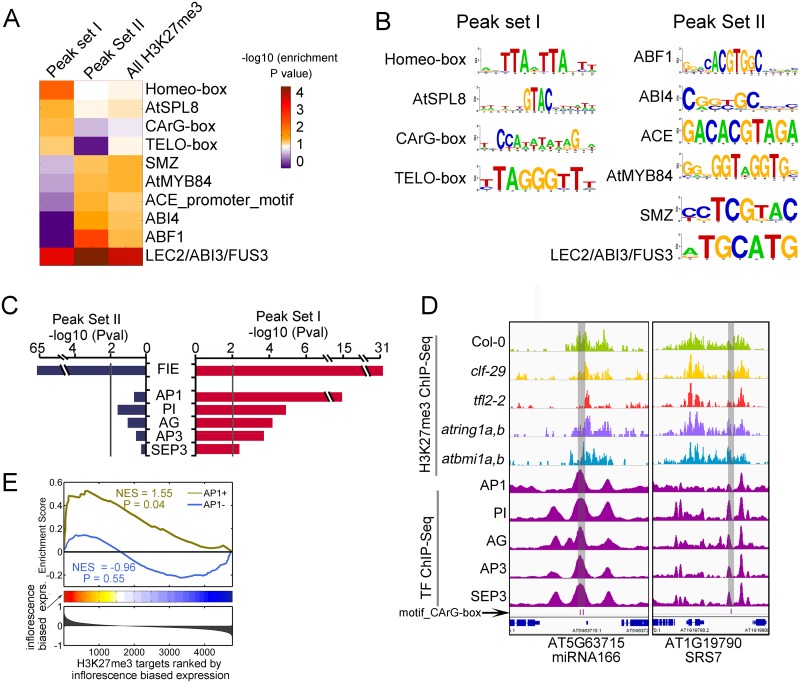
TF binding motifs and TFs whose bindings enriched in peak set I and peak set II.(A) Heatmap showing enriched motifs (P value < 0.01) in either peak set I or peak set II. Their enrichment in H3K27me3 peaks in Col-0 are also shown. (B) Sequence LOGOs of motifs enriched in peak set I and peak set II. (C) Enrichment of the binding sites of FIE and TFs in peak set I. (D) IGV screen shots showing examples of co-occupancy between H3K27me3 in seedlings and the bindings of MADS-box TFs in inflorescence. The motif sites of MADS box TFs are indicated by pink and blue bars at bottom of the screen shots, and are highlighted by grey area. (E) GSEA showing the common target genes of peak set I and AP1 binding peaks are preferentially expressed in inflorescence.